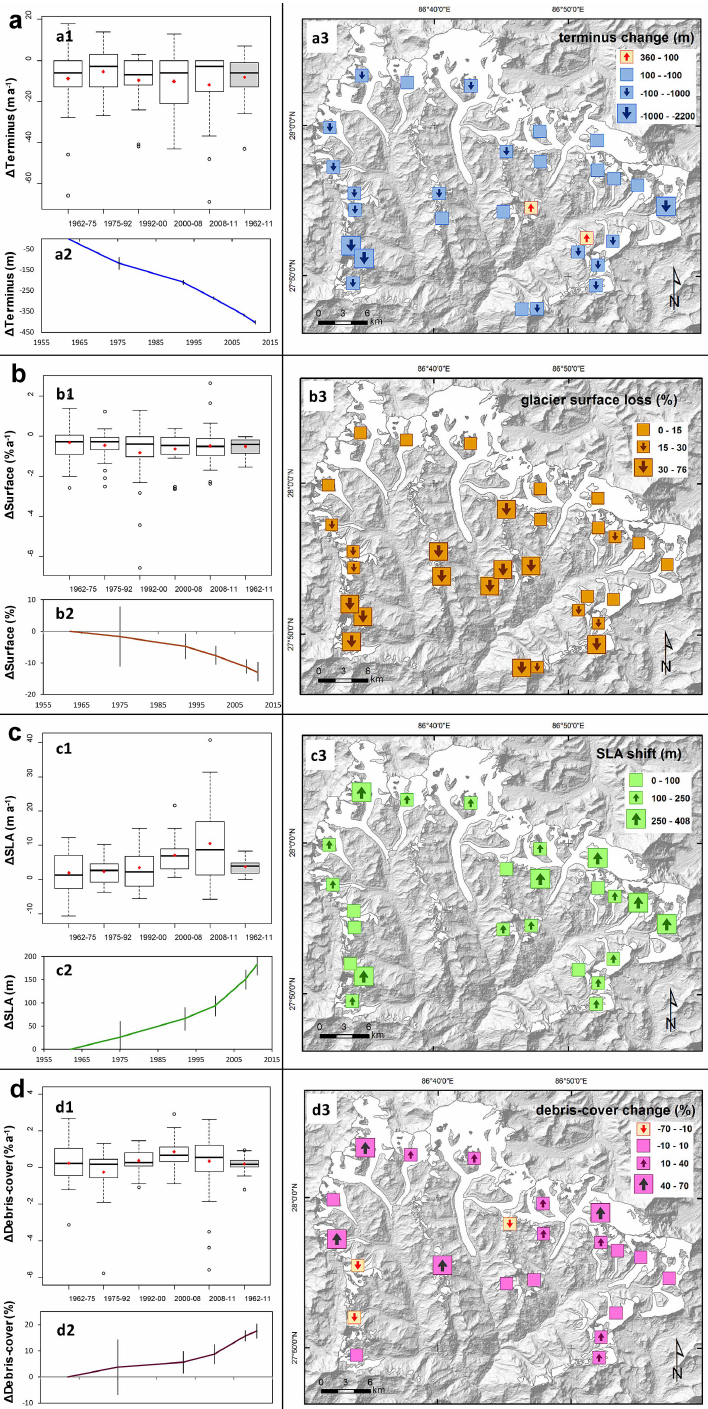
Figure 3. Spatio-temporal changes in Mt. Everest region; (a) terminus position change ( 1 Term), (b) surface area change ( 1 Surf), (c) shift of snow-line altitude ( 1 SLA), and (d) debris area coverage change ( 1 DebrisCov). For each plot, upper left box plot represents the annual rates of change of the glaciers in the analyzed periods. The red point in the box indicates the mean. The lower left plot describes the cumulative changes with associated uncertainty. On the right side, the map represents the spatial variation of the glaciers. Data are in Table S1 of the Supplement. All percentages refer to the initial year of the analysis